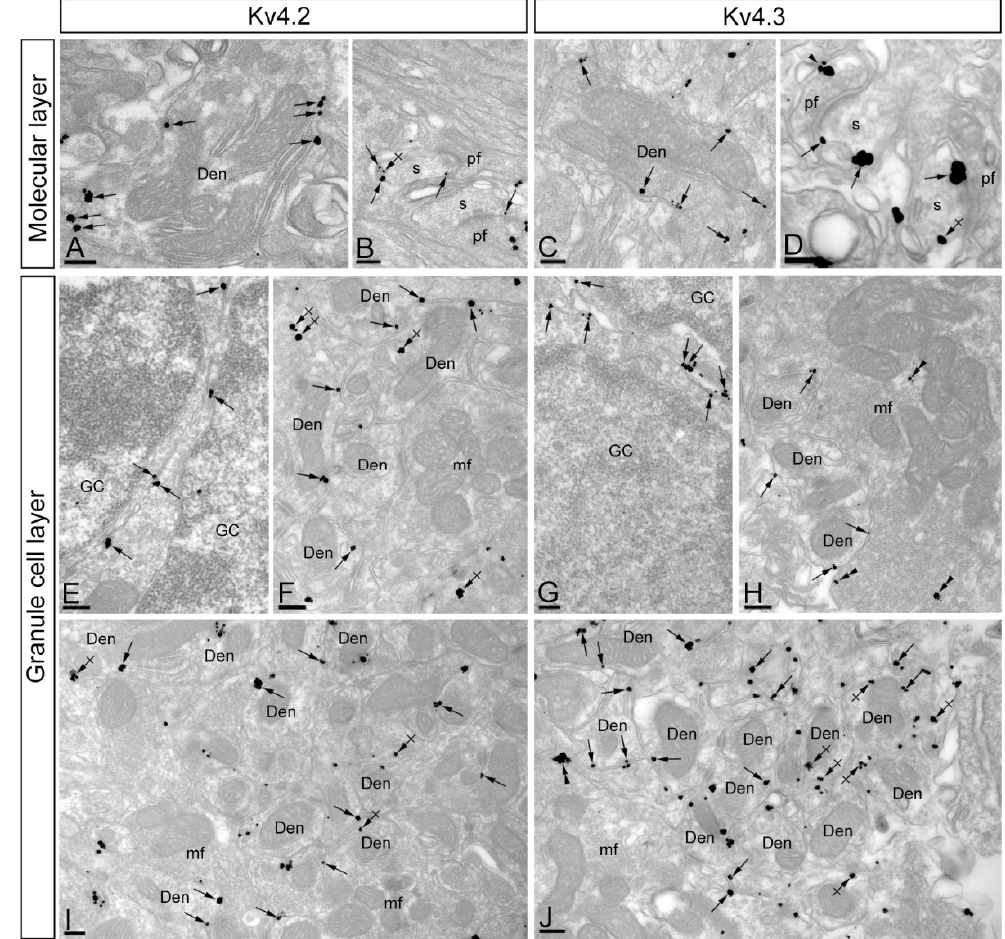
Figure 7. Subcellular distribution of voltage-gated potassium (Kv) channel subunits Kv4.2 and Kv4.3 channels. Immunoreactivity for Kv4.2 and Kv4.3 in the cerebellar cortex as demonstrated by pre-embedding immunogold labelling. ( A – D ) Immunoparticles for both Kv4.2 and Kv4.3 in the molecular layer were found in the plasma membrane (arrows) and intracellular sites (crossed arrows) of PC dendrites (Den) and spines (s) establishing synapses with parallel fibres (pf). Although, at low frequency, Kv4.3 immunoparticles were also found in the plasma membrane (arrowheads) of parallel fibres (pf). ( E – J ) Immunoparticles for both Kv4.2 and Kv4.3 in the granule cell layer were found in the plasma membrane (arrows) of GC somata and GC dendrites (Den) in cerebellar glomeruli. In addition, immunolabelling was found intracellularly (crossed arrows). Few immunoparticles were also observed presynaptically along the plasma membrane (arrowheads) and intracellular sites (double arrowheads) in mossy fibre (mf) axon terminals. Scale bars: A – J , 200 nm.